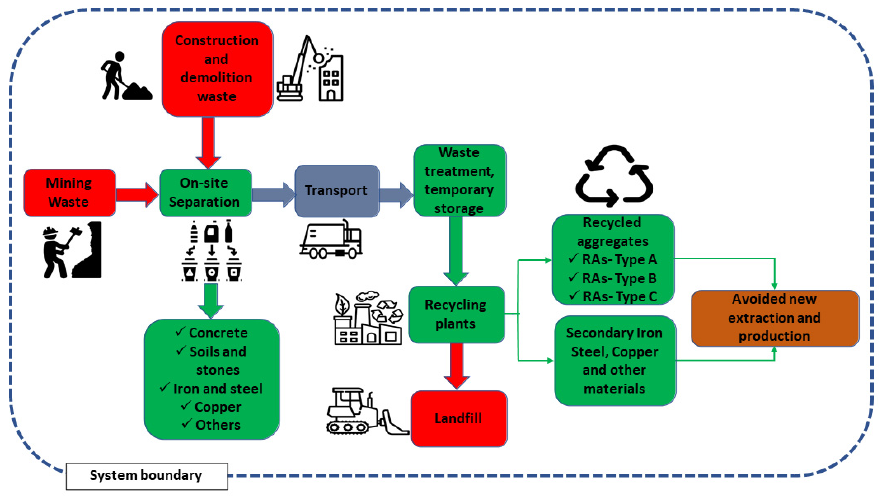
Figure 3. System boundaries of the LCA study.